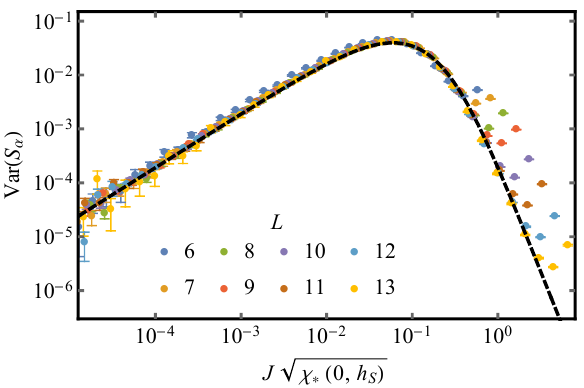
Figure 8: Variance of the eigenstate entanglement entropies of the spin : the numerically ensemble averaged variance (coloured points) is plotted as a function of J for mid-spectrum states of the Spin-ETH model for different L (legend inset). Data corresponds to the same realisations as Fig. 7. The theoretical curve (black dashed) is calculated from the distribution